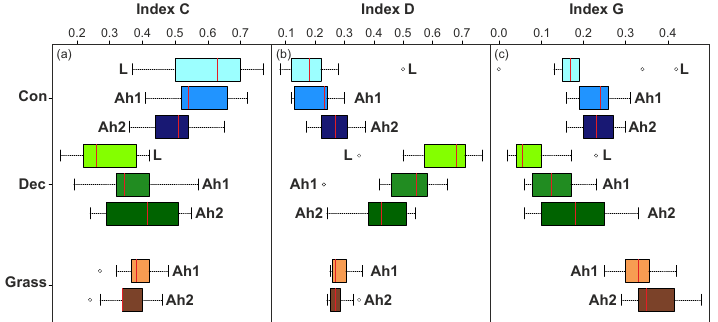
Figure 6. Box plots for (a) indices C, (b) D and (c) G. Con: coniferous forest sites ( n = 9); dec: deciduous forest sites ( n = 14); grass: grass- land sites ( n = 14); L: litter; Ah1: topsoil 1 (0–3cm); Ah2: topsoil 2 (3–10cm). Box plots show median (red line), interquartile range (IQR) with upper (75%) and lower (25%) quartiles, lowest datum still within 1.5 × IQR of lower quartile, and highest datum still within 1.5 × IQR of upper quartile.